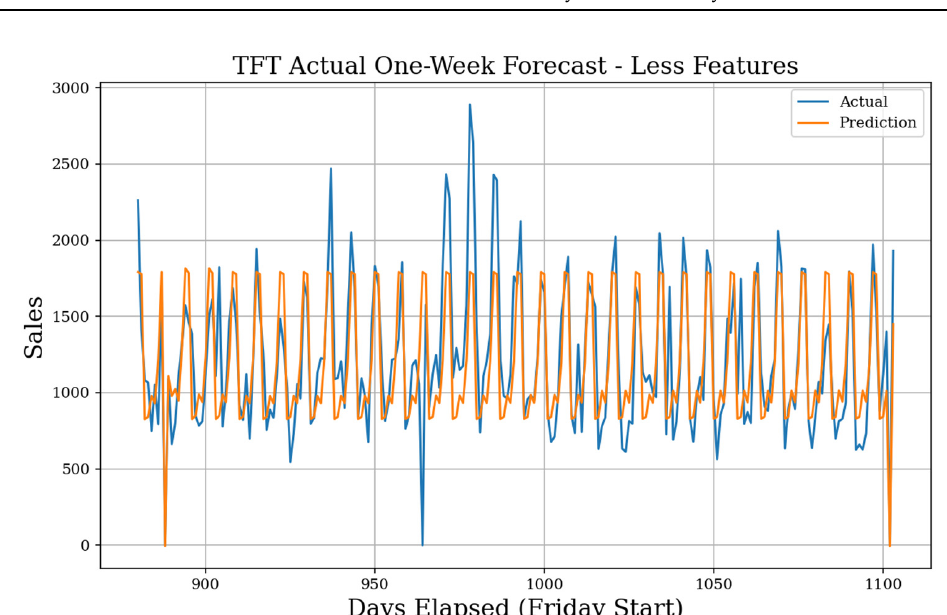
Figure 16. Transformer Less Features Actual One-Week Forecast. The best start day MAE of 216 is found when starting on Tuesday. A sMAPE of 20.2% and gMAE of 123 show we may look for more improvements in the future, as results are not as good overall as one-day. A mean MAE of 218 and a standard deviation of 1.29 are found with 17 features. TFT perfectly captures the two holiday zero-sale days without acknowledging the zero-sale ‘hurricane day.’.